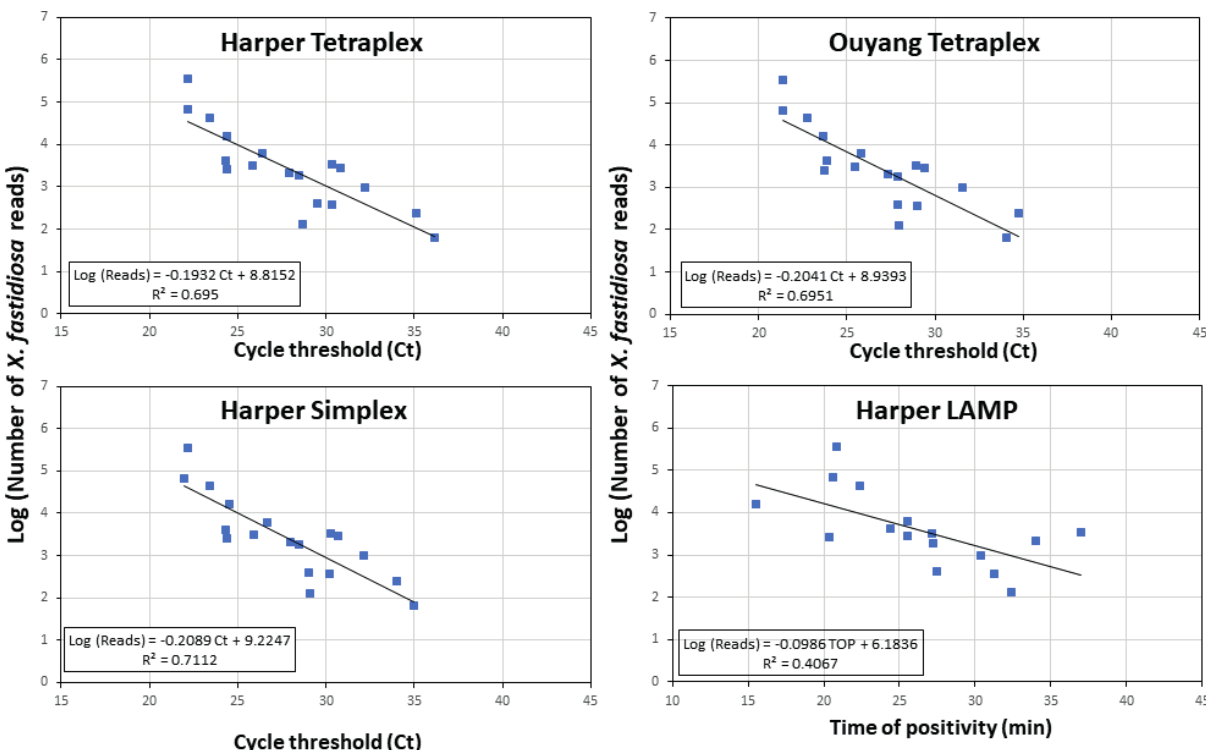
Figure 2. Linear regressions between Log [ Xylella fastidiosa reads] obtained by next generation sequencing (NGS) and Ct values from quantitative polymerase chain reaction (qPCR) protocols of Ouyang tetraplex and Harper tetraplex (Bonants et al. , 2019), Harper Simplex (Harper et al. 2010), and LAMP test based in Harper et al. (2010). Data were obtained from Table 7 of Bonats et al. (2019), and represent the mean Ct value obtained for each